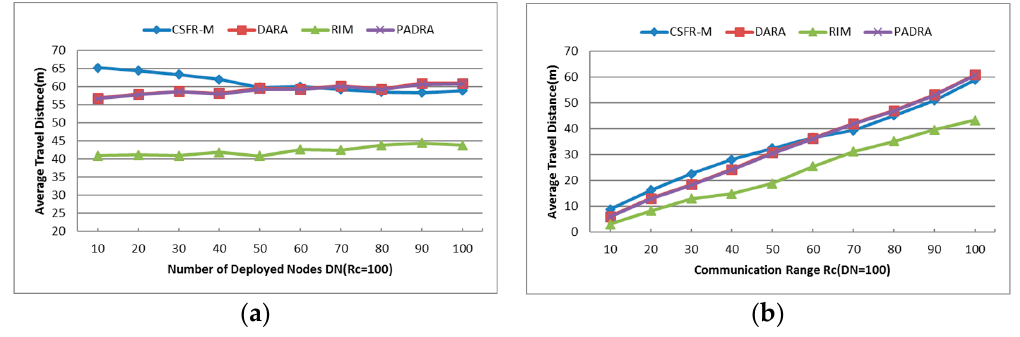
Figure 11. ( a ) TD with different DN; and ( b ) TD with different R c